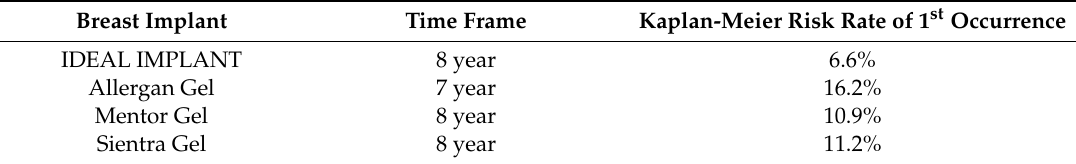
Table 2. Capsular contracture Baker III / IV. FDA trial data for primary augmentation. Breast Table 1. Deflation/Rupture (MRI Cohort). FDA trial data for primary augmentation. Breast Implant